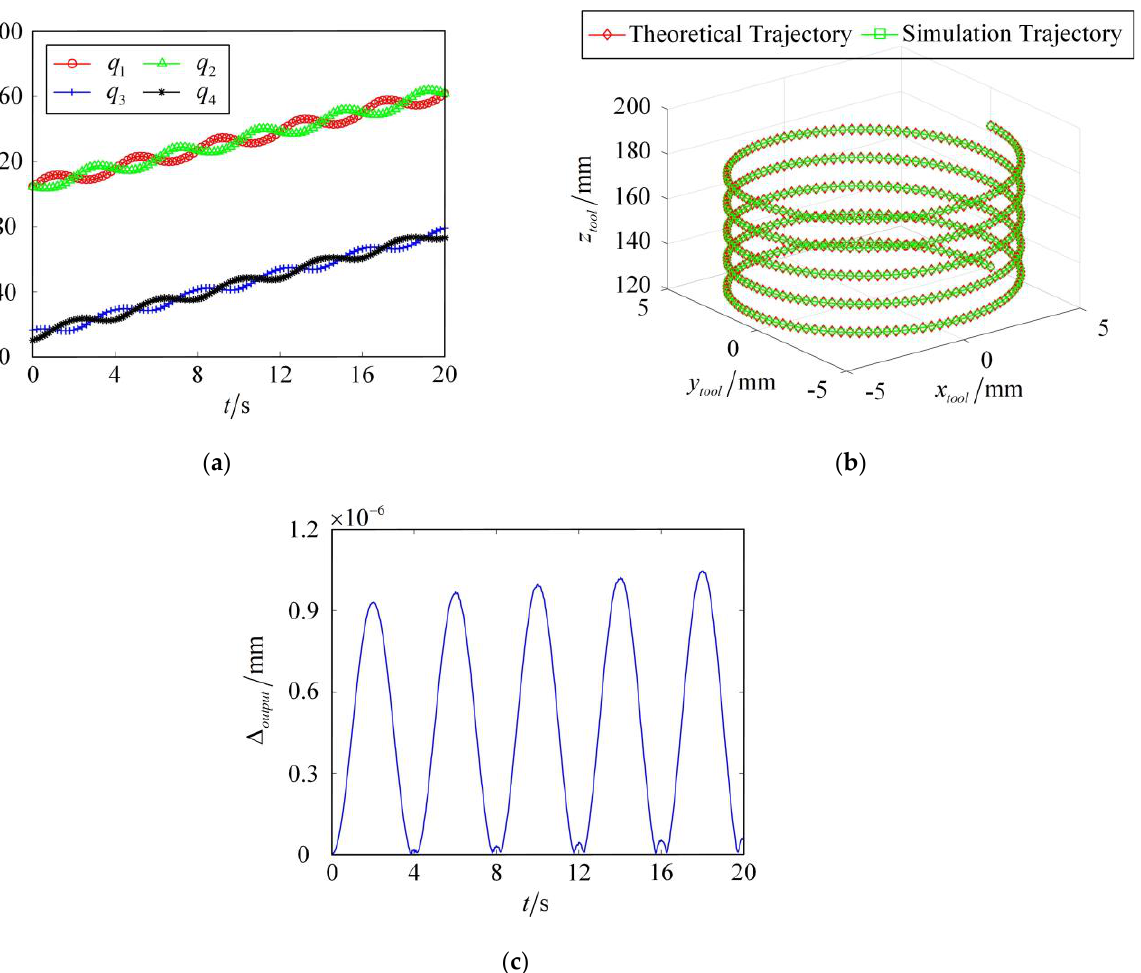
Figure 2. Comparisons of simulation and theoretical results in a given helical trajectory: ( a ) actuated displacements of q i ; ( b ) simulation and theoretical trajectories; ( c ) distance errors between the simulation and theoretical